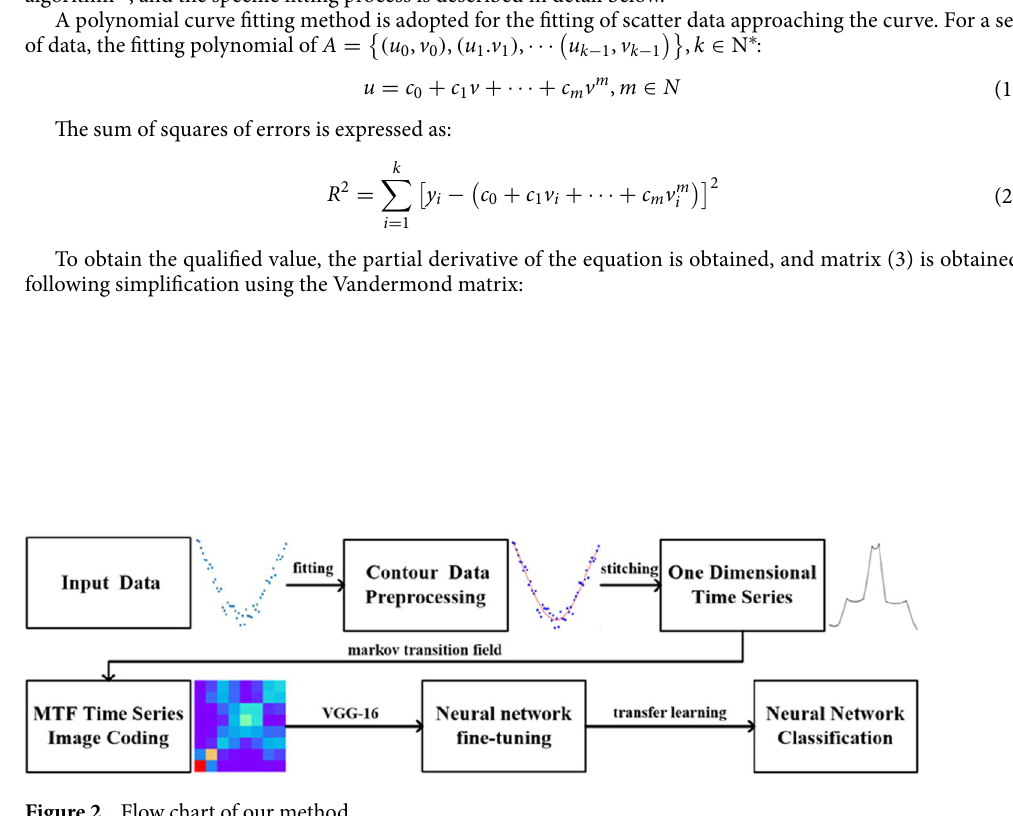
Figure 2. Flow chart of our